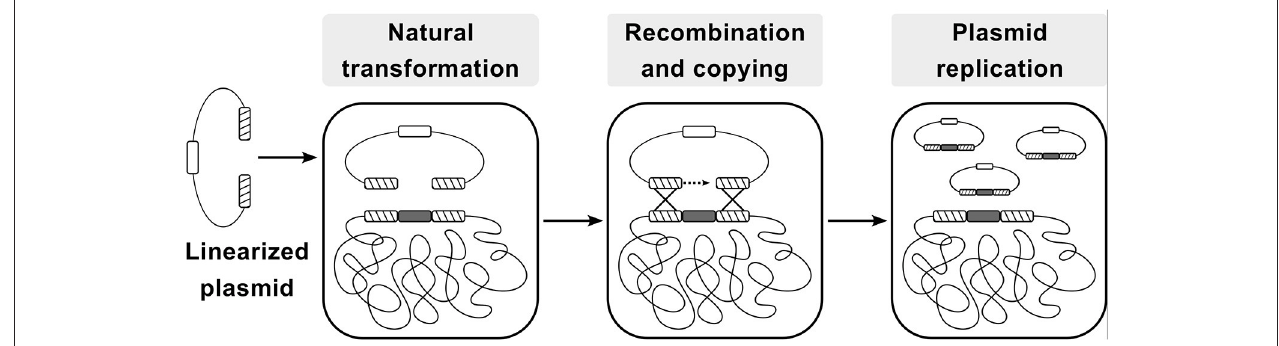
FIGURE 1 | Flow-chart of the CopySwitch method; after linearization of a replicative plasmid (via restriction or PCR), it is taken up by Bacillus subtilis via natural transformation. Regions homologous to the chromosome are recombined and the DNA sequence between the regions is copied onto the plasmid. Hatched blocks: homology regions; dark gray blocks: sequence of interest; white block: low copy number ori ; Adapted from Tsuge and Itaya (Tsuge and Itaya,